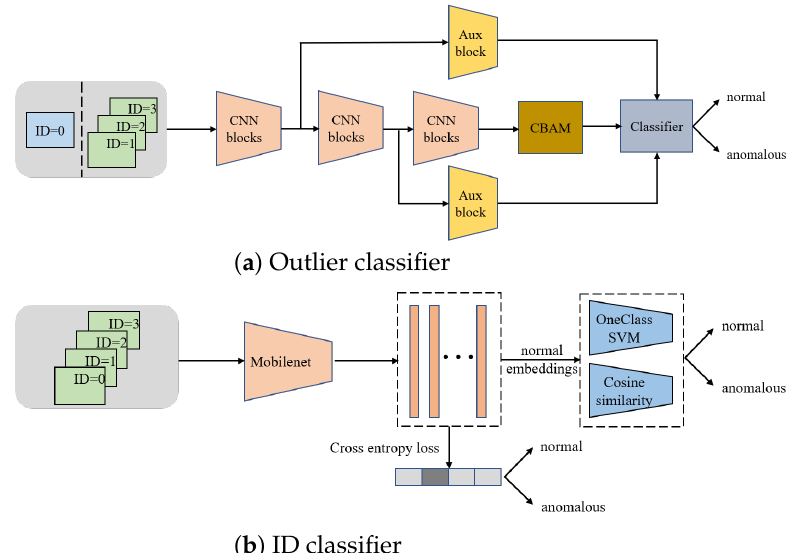
Figure 2. ( a ) The Outlier classifier distinguishs the outliers which are considered as anomalies from the normal, and it directly outputs the anomaly scores of unseen sounds. ( b ) The ID classifier identifies different machine IDs. For the ID classifier, we use two methods for anomaly detection as shown in Figure 2b, the first is to calculate the similarity between unseen sounds and normal sounds using embeddings extracted from the hidden layer, another method uses the confidence of classification.